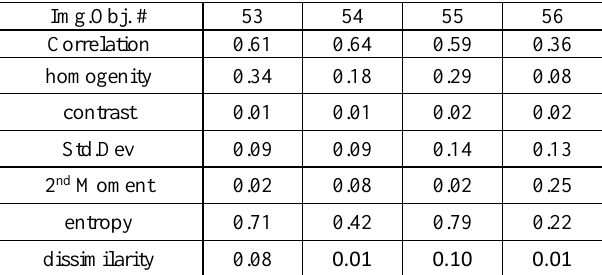
Table 2. Pre-event feature values for four sample image objects.